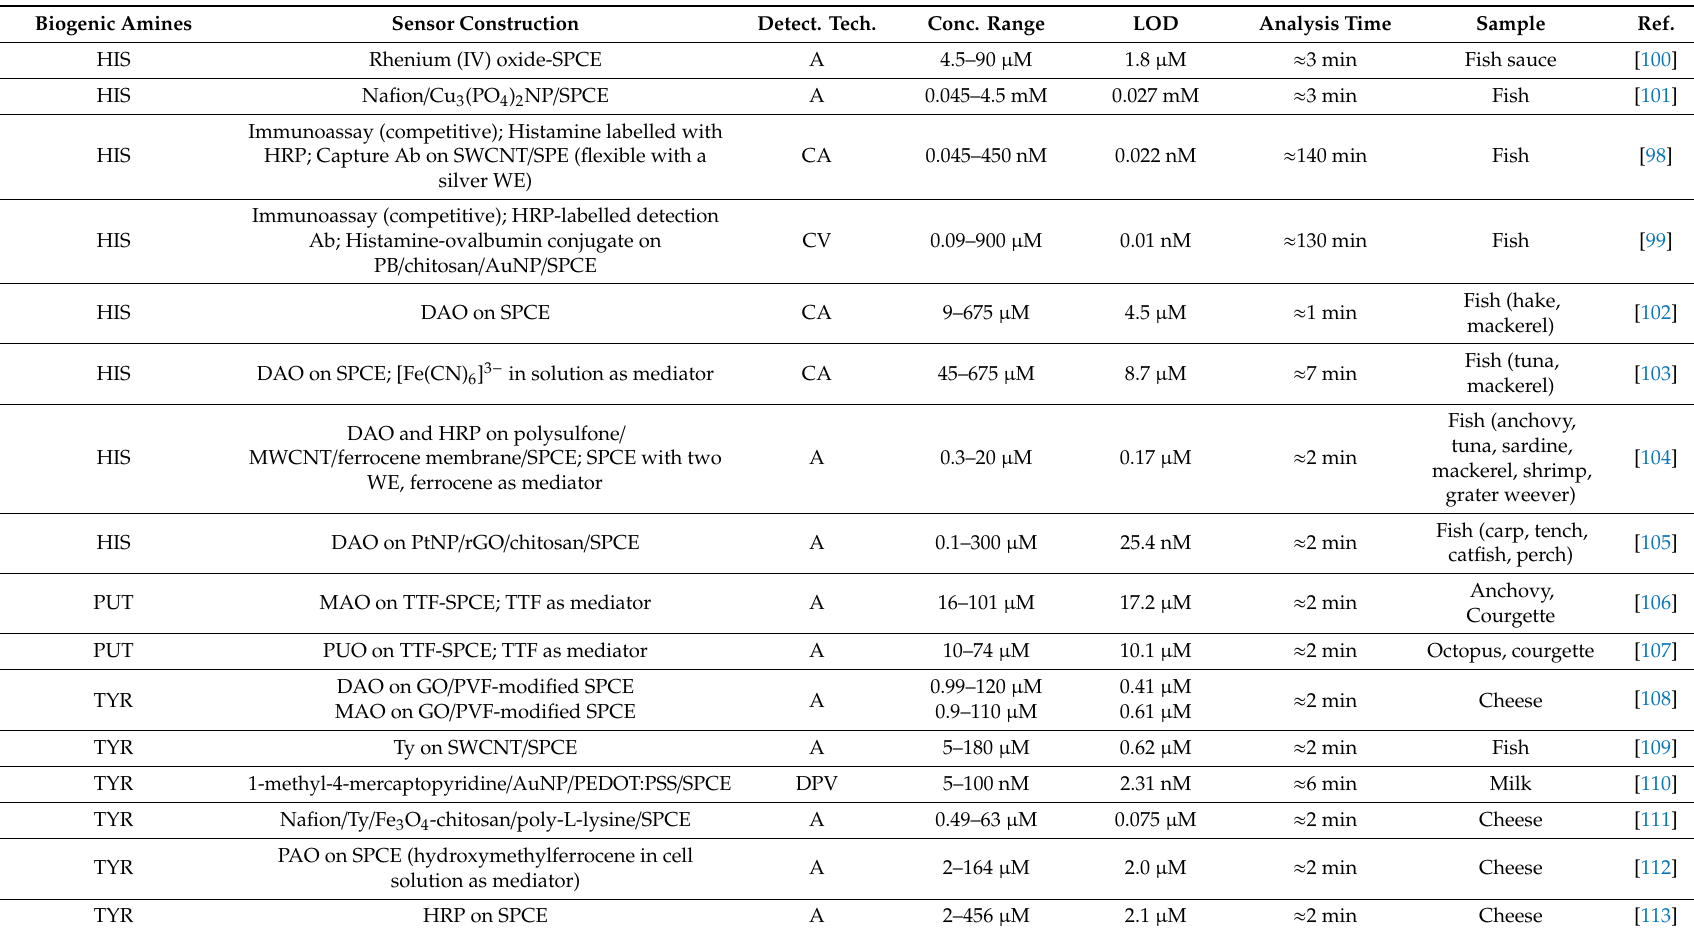
Table 4. SPE-based sensors for biogenic amines detection in food